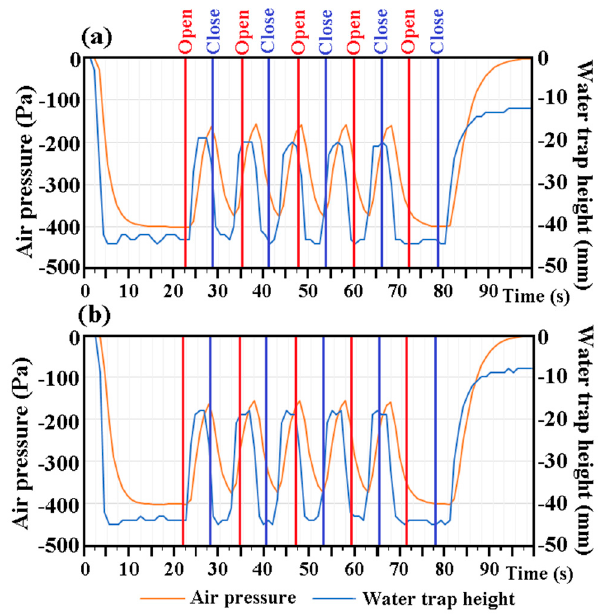
Figure 11. Temporal variations of water trap level and air pressure in gully drums with ( a ) beveled and ( b ) downward nozzle flows.